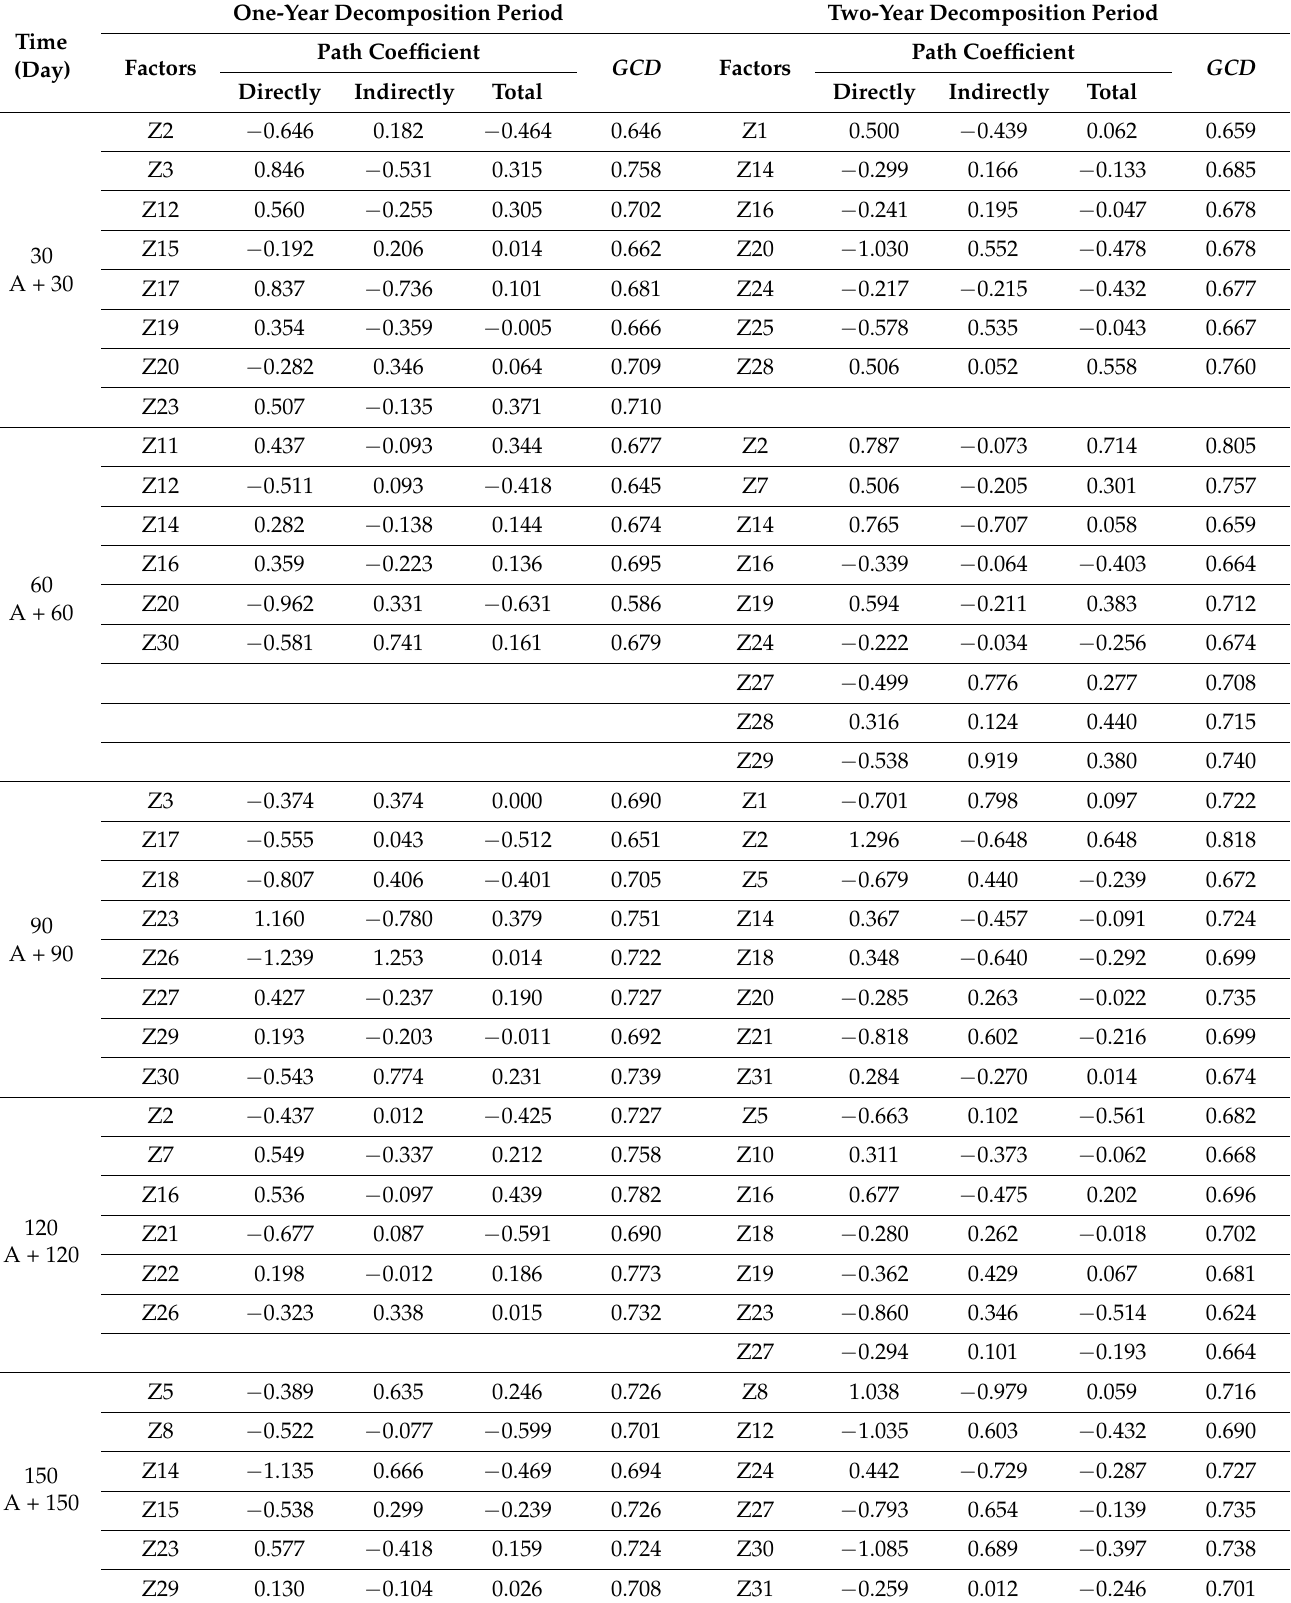
Table 3. The results of path analysis and grey correlation